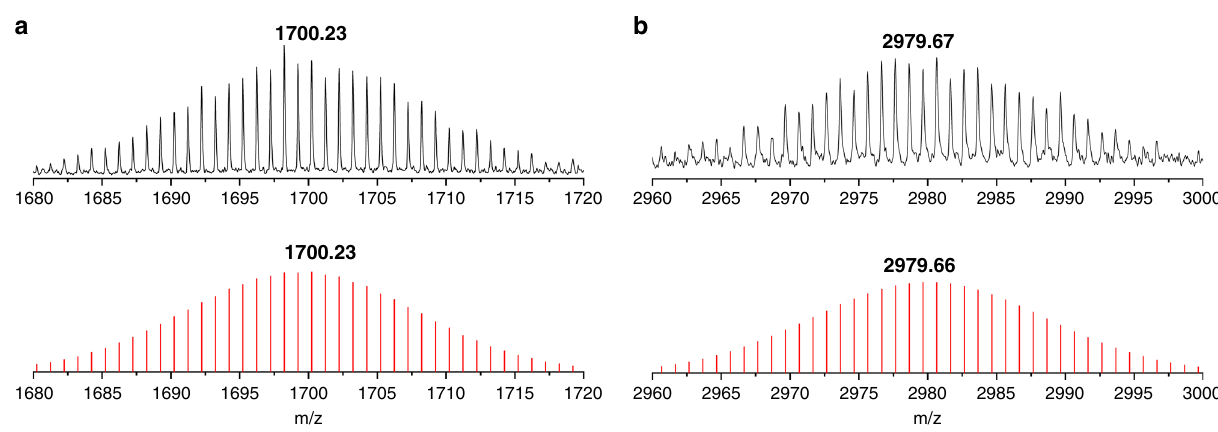
Fig. 3 Negative-ion ESI mass spectra. a Spectrum of {(Ge 9 ) 2 [ η 6 -GePd 3 ]} − fragment. b Spectrum of {[K 3 (2,2,2-crypt)]{(Ge 9 ) 2 [ η 6 -Ge(PdPPh 3 ) 3 ]} − fragment. Top: measured spectrum. Bottom: calculated spectrum.